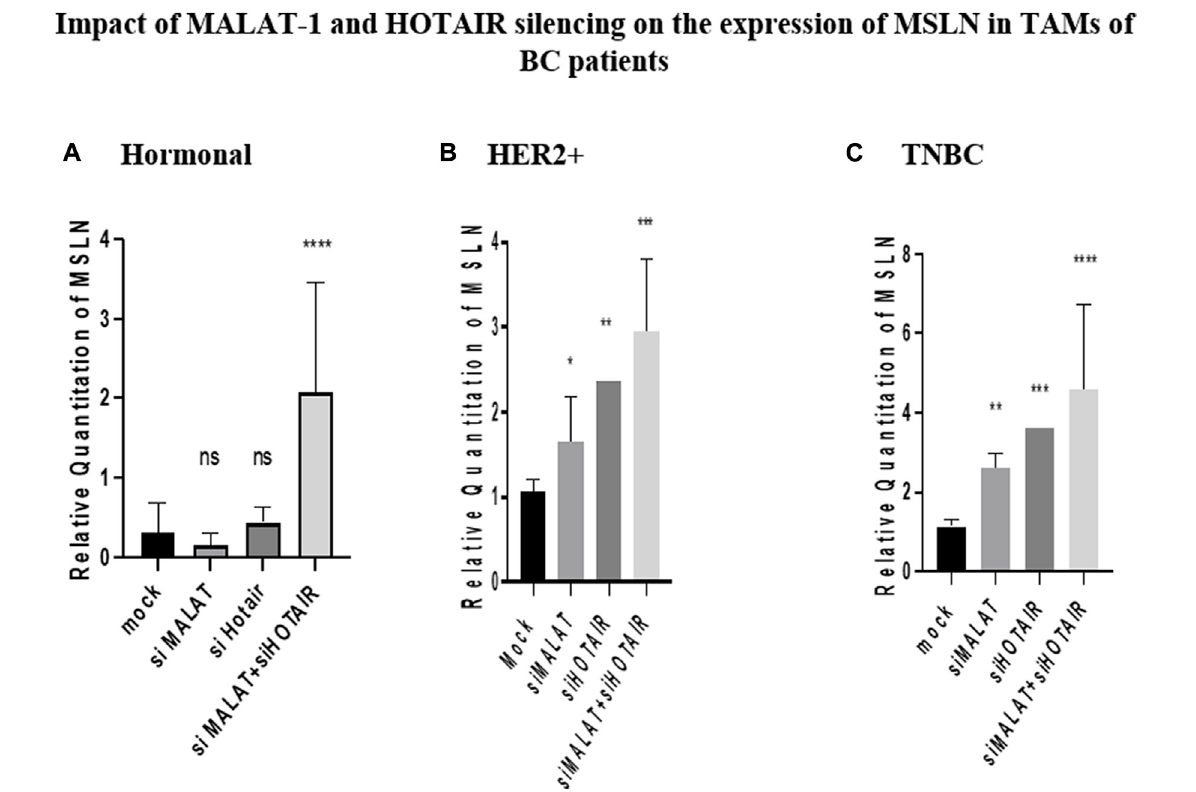
FIGURE 7 Impact of MALAT1 and HOTAIR silencing on the expression of MSLN in TAMs of (A) hormonal, (B) HER2+, and (C) TNBC. MSLN mRNA levels were measured using qRT-PCR and were normalized to β -actin that functioned as an endogenous control. The results show that MALAT1 silencing resulted in statistically signi fi cant upregulation of MSLN in HER2+ and TNBC subtypes; however, more signi fi cant upregulation of MSLN was observed on transfection with silencer against HOTAIR when compared to the untransfected controls (mocks) of the same subtypes. Conversely, MSLN expression showed no signi fi cant change in expression upon silencing MALAT1 or HOTAIR in TAMs of the hormonal subtype compared to the untransfected controls (mocks) of the same subtype. Meanwhile, the co-transfection of HOTAIR silencers with MALAT1 silencers resultedinthemostsigni fi cantupregulationpro fi leforMSLNinTAMsofthethreesubgroupsincomparisontountransfectedcontrols(mocks).One- way Anova followed by Dunette ’ s test of multiple comparison was used for the purpose of comparison between more than two different